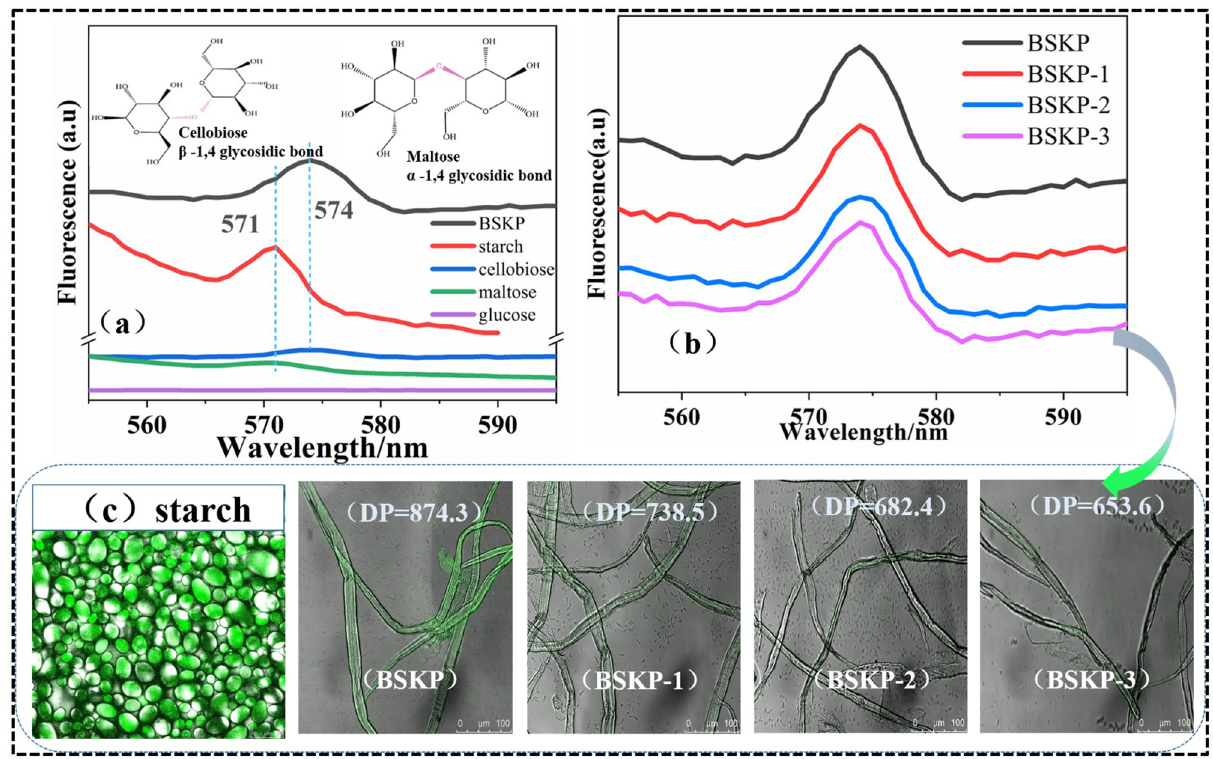
Figure 4. Comprehensive comparison of the fluorescent properties caused by glycosidic bonds. ( a ) Comparison of fluorescence properties of α-1, 4 glycosidic bond and β-1, 4 glycosidic bond. Inset: molecular configuration of